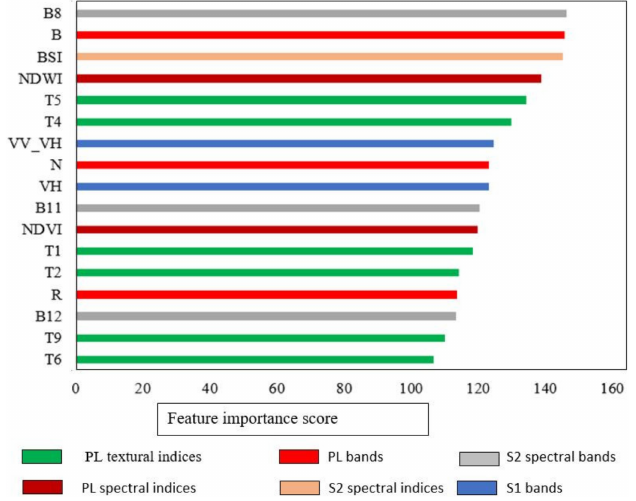
Figure 5. Importance assessment of LULC classification features. Features’ codes are reported in Tables 1 and